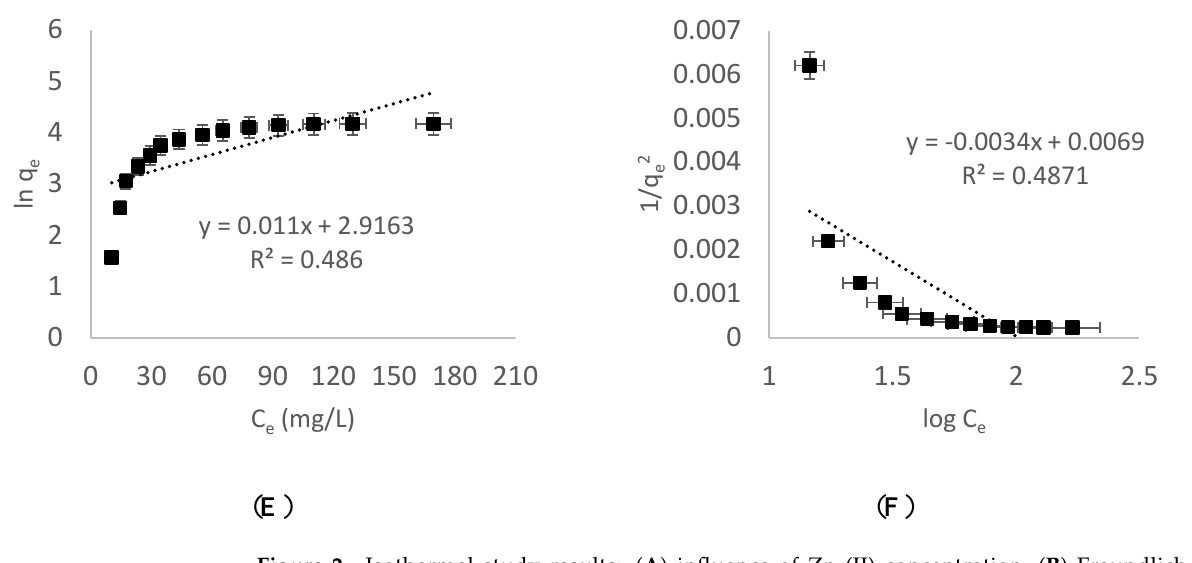
Figure 2. Isothermal study results: ( A ) influence of Zn (II) concentration, ( B ) Freundlich plot, ( C ) Langmuir isotherm, ( D ), Temkin isotherm, ( E ) Jovanovic plot, ( F ) Harkins–Jura plot.